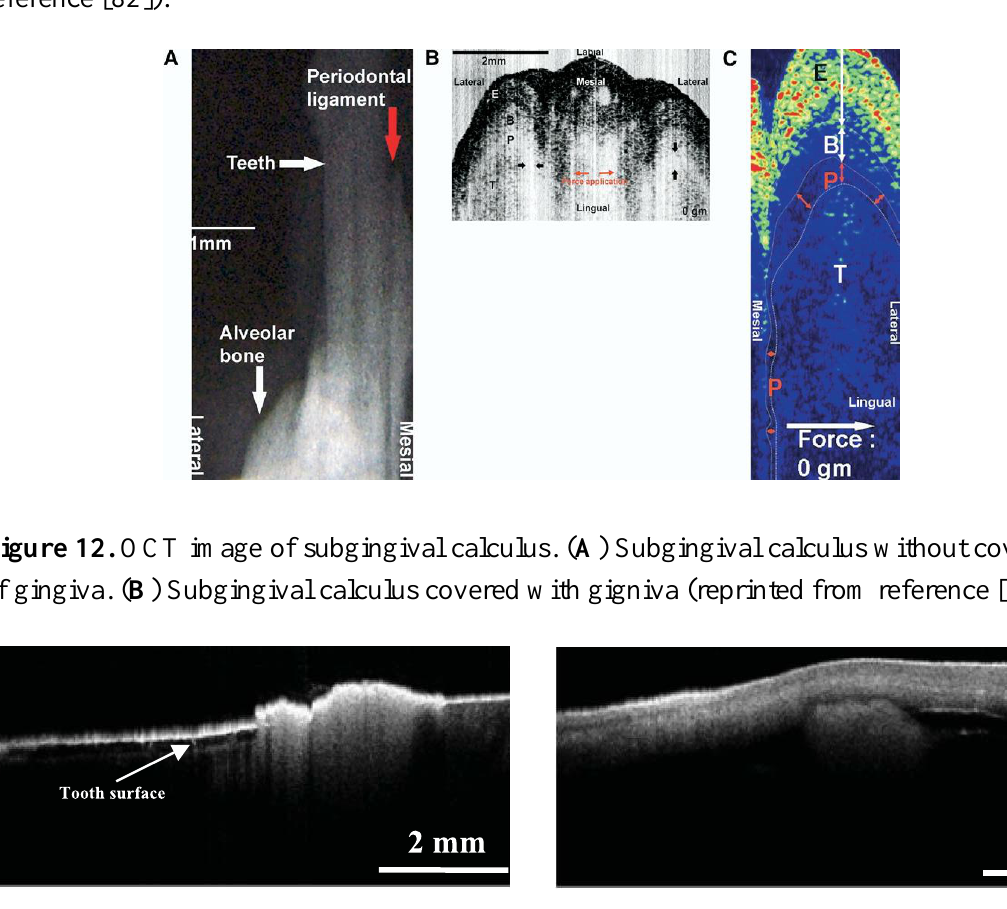
Figure 11. Images of a periodontal ligament. ( A ) Radiograph. ( B ) OCT. ( C ) Logging OCT images; the boundary of each tissue can be identified more clearly (reprinted from reference [82]).